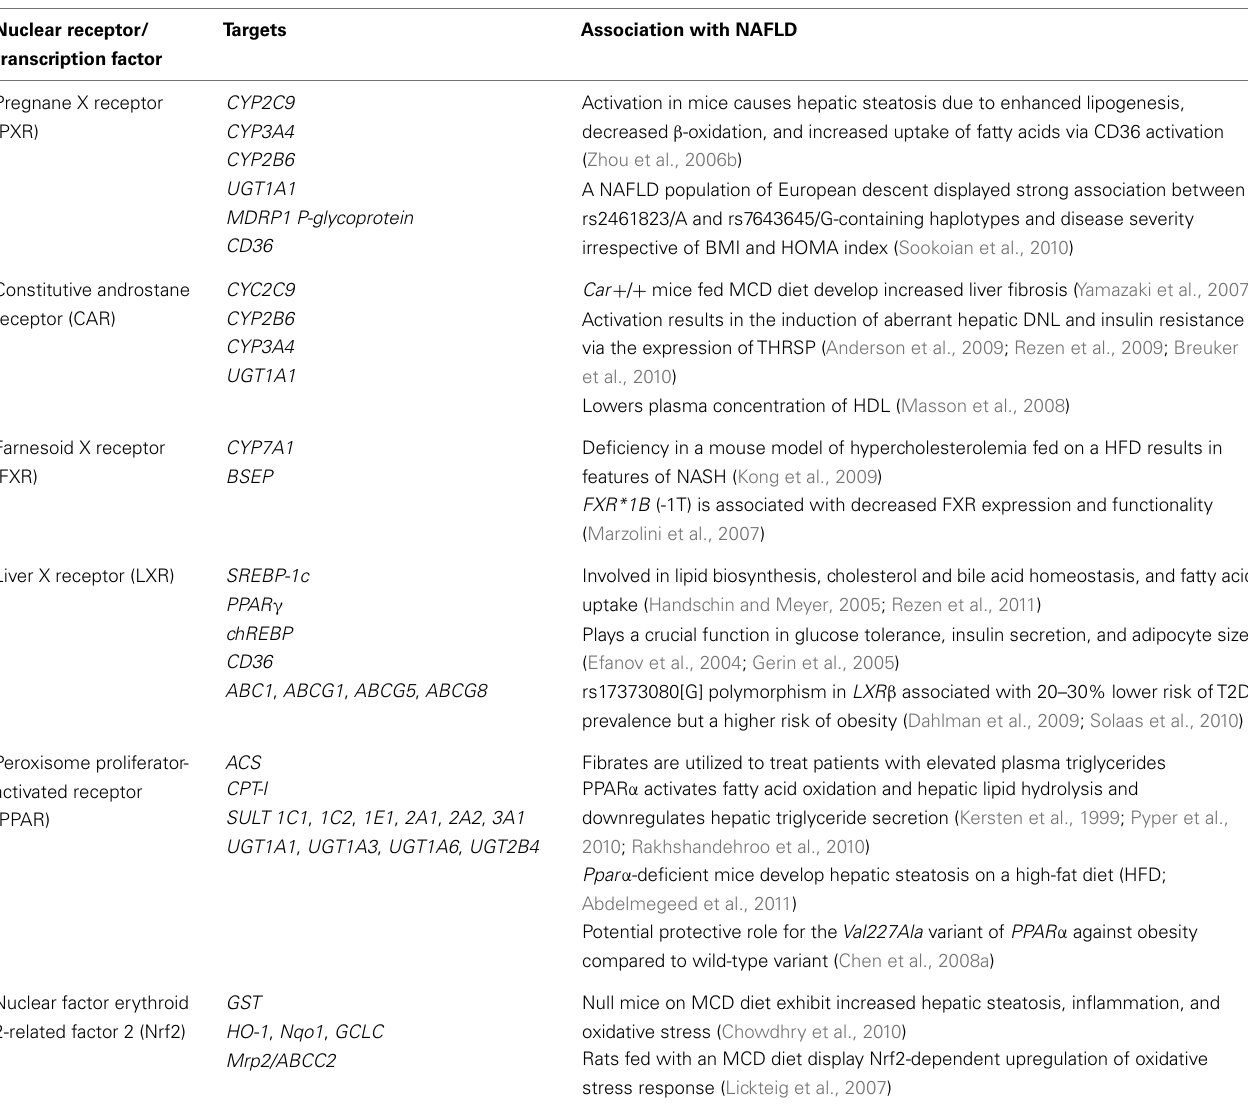
Table 1 | Nuclear receptors and transcription factors in interaction between NAFLD and drug